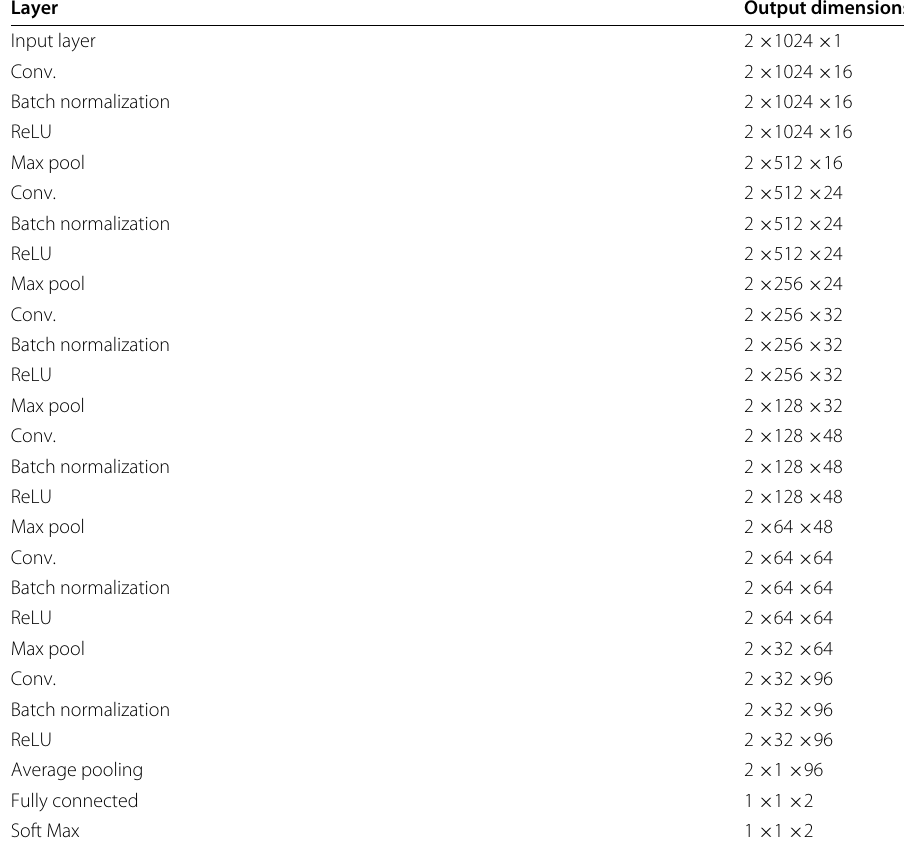
Table 1 The first adopted CNN network layout